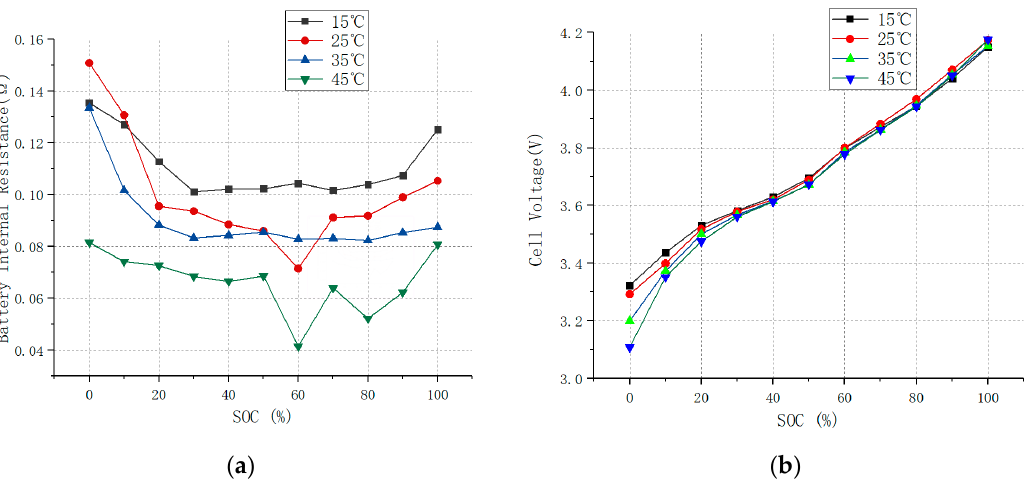
Figure 6. Internal resistance and open circuit voltage characteristics of the battery: ( a ) Description of what is contained in the first panel; ( b ) Description of what is contained in the second panel.